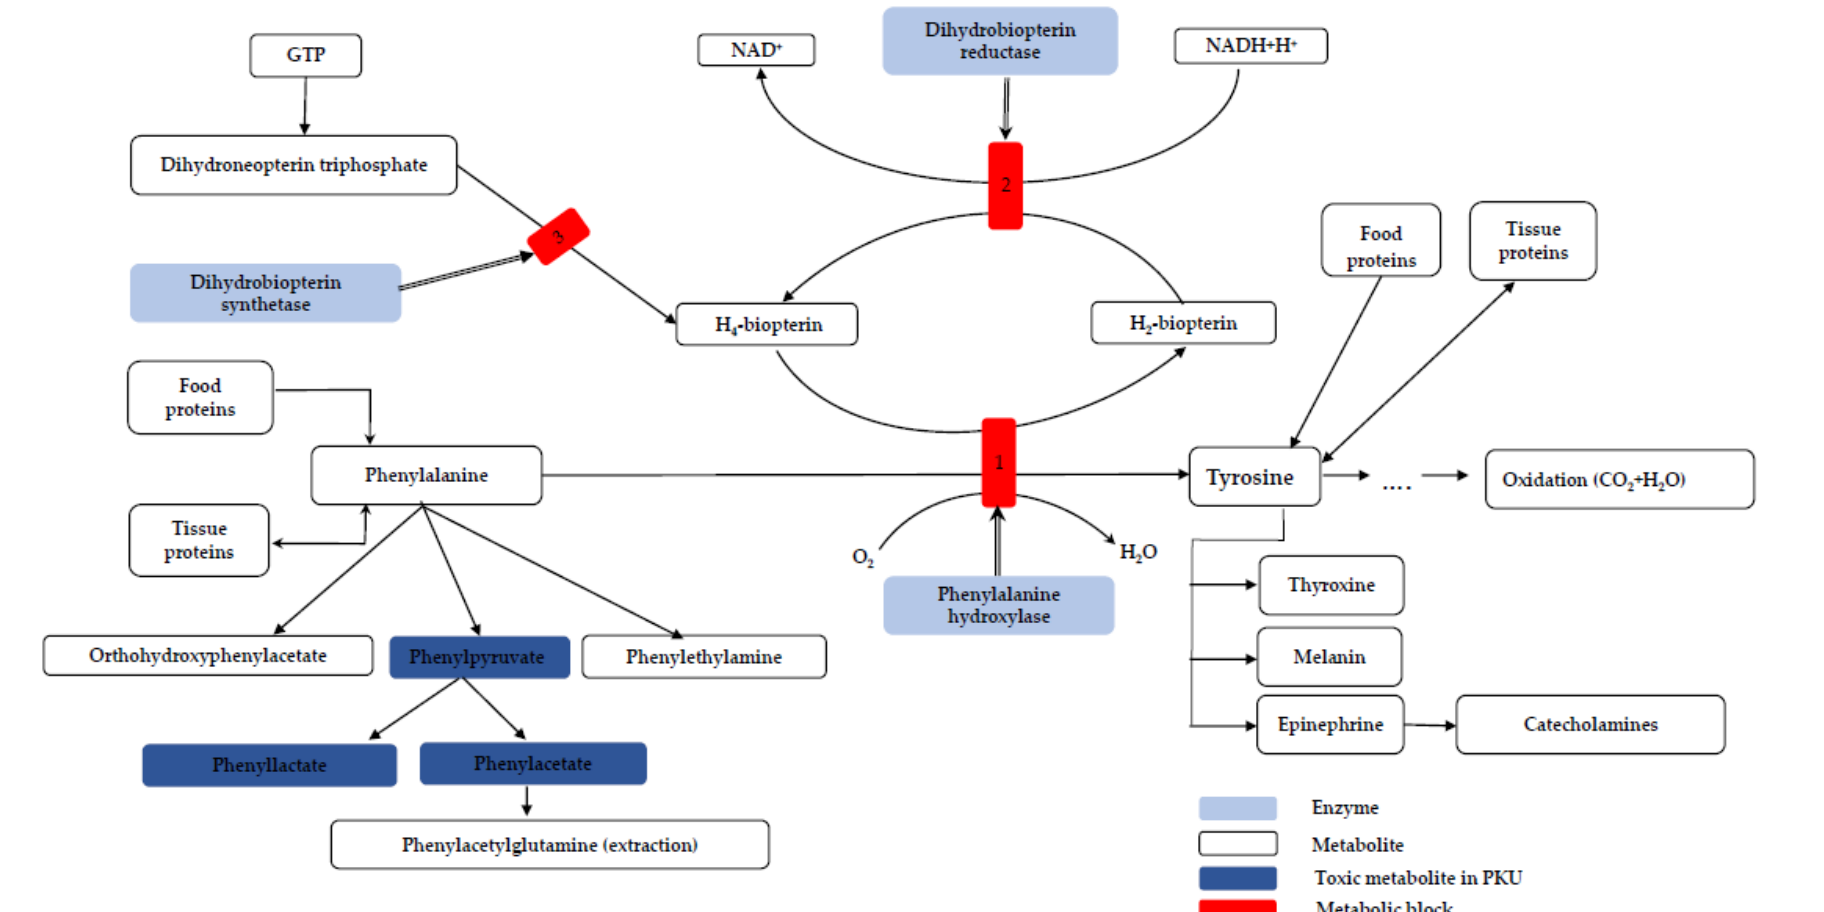
Figure 2. Scheme of metabolic processes that determine the mechanism of phenylketonuria development [14]: metabolic block 1—in case of phenylalanine hydroxylase deficiency (classical phenylketonuria); metabolic blocks 2–3—in case of various forms of BH 4 deficiency (phenylalanine hydroxylase-independent hyperphenylalaninemia).